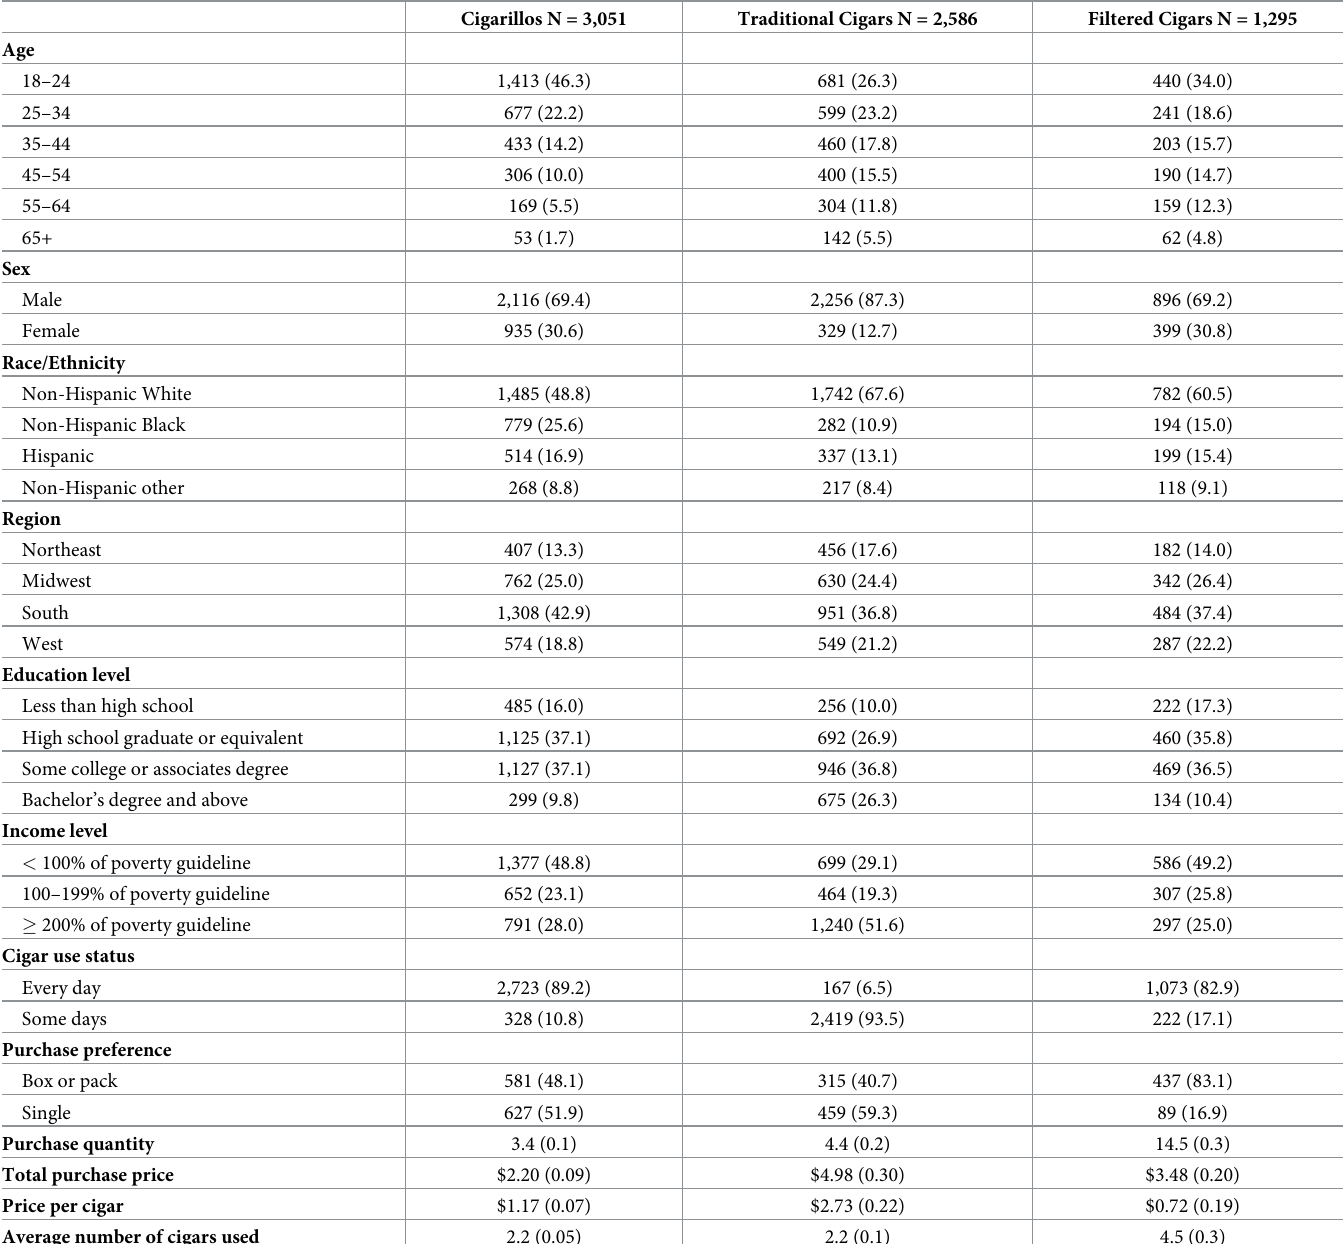
Table 1. Demographic characteristics of Wave 1 current cigarillo, traditional cigar, and filtered cigar